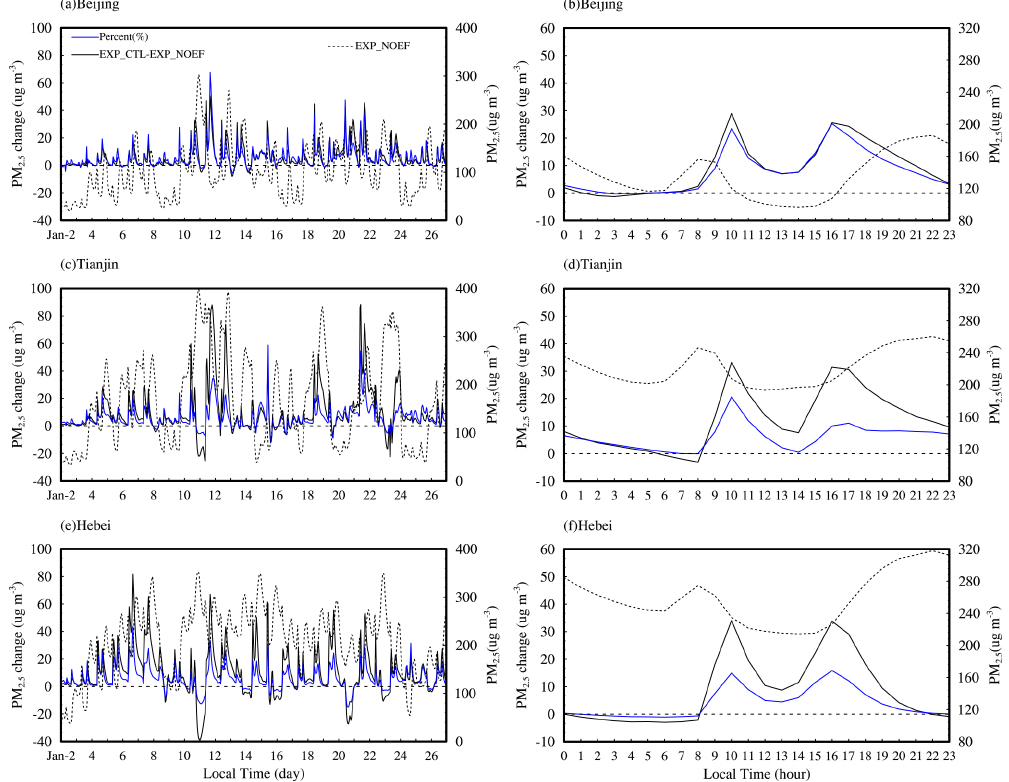
Figure 11. Time series of surface PM 2 . 5 concentration from EXP_NOEF and the hourly surface PM 2 . 5 concentration (µgm − 3 ) change induced by meteorological variable change averaged for (a) Beijing, (c) Tianjin, and (e) Hebei during 2–26 January and the corresponding diurnal change averaged for (b) Beijing, (d) Tianjin, and (f) Hebei during 10–15 January 2013. The black solid line denotes the change value of surface PM 2 . 5 concentration and the blue solid line denotes the corresponding change in percentage terms compared to the surface PM 2 . 5 concentration from the model results of EXP_NOEF. Beijing, Tianjin, and Hebei comprise the BTH region (dashed blue boxes in Fig. 1).